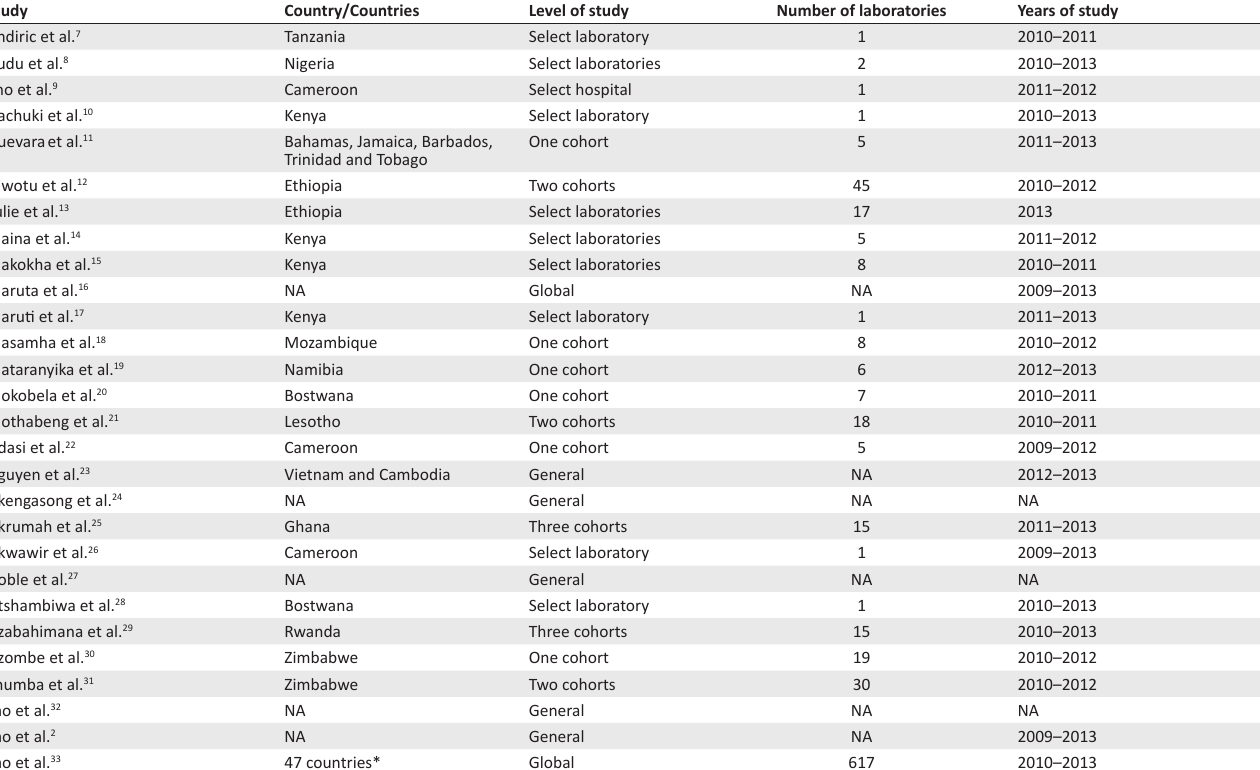
TABLE 1: Characteristics of published SLMTA